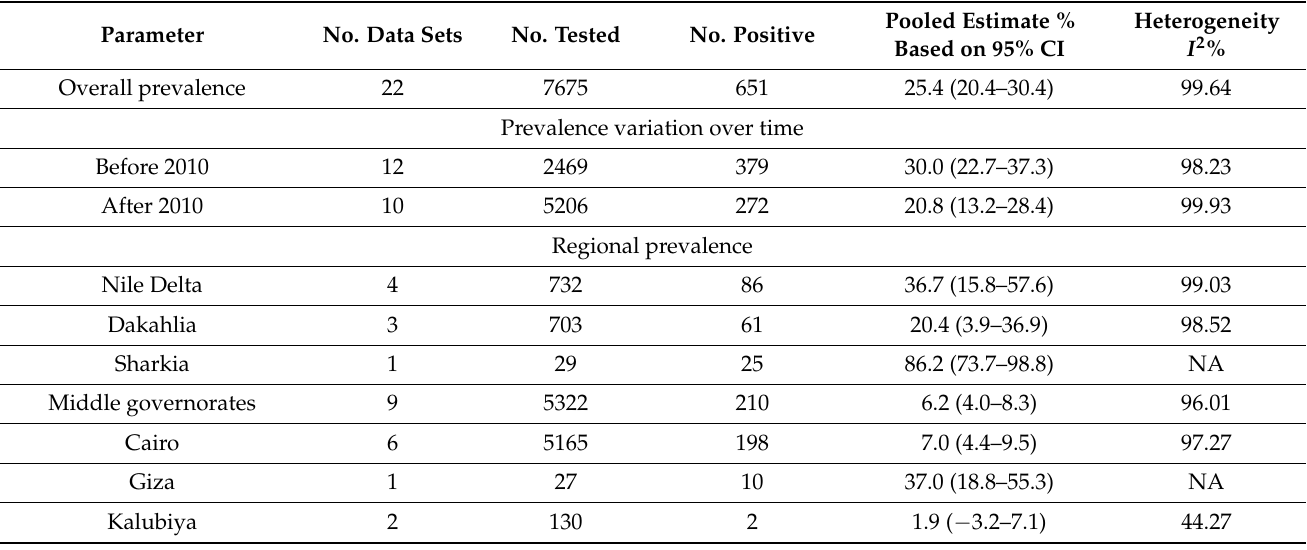
Table 8. Overall and regional prevalence of Dipylidium caninum in dogs from various Egyptian regions, and variabilities according to dog life